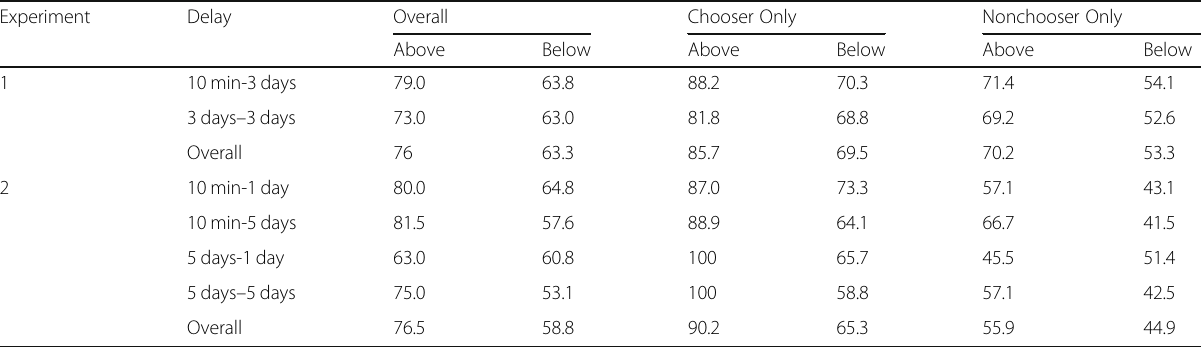
Table 3 Experiments 1 and 2: The Percentages of Consistent Responses Above and Below a Confidence Rating of 90% Experiment Delay Overall Chooser Only Nonchooser Only